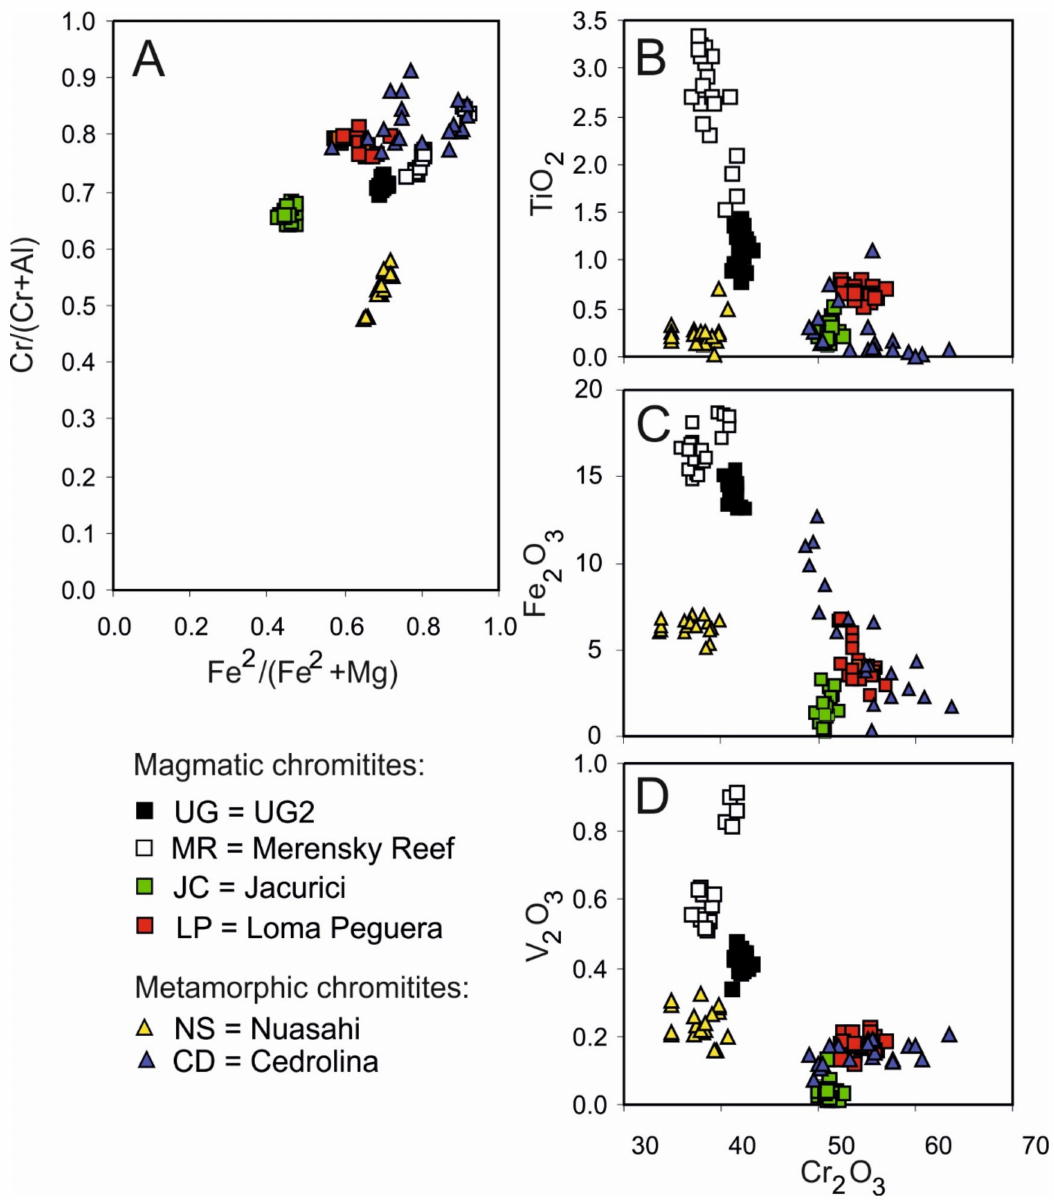
Figure 3. Variation of chromite composition in the chromitite samples investigated in this work. Chromium number Cr/(Cr + Al) versus bivalent iron number Fe 2 /(Fe 2 + Mg) (concentration as atoms %) ( A ). Correlation between TiO 2 , Fe 2 O 3 and V 2 O 3 as function of Cr 2 O 3 (concentrations as oxide weight %) ( B – D